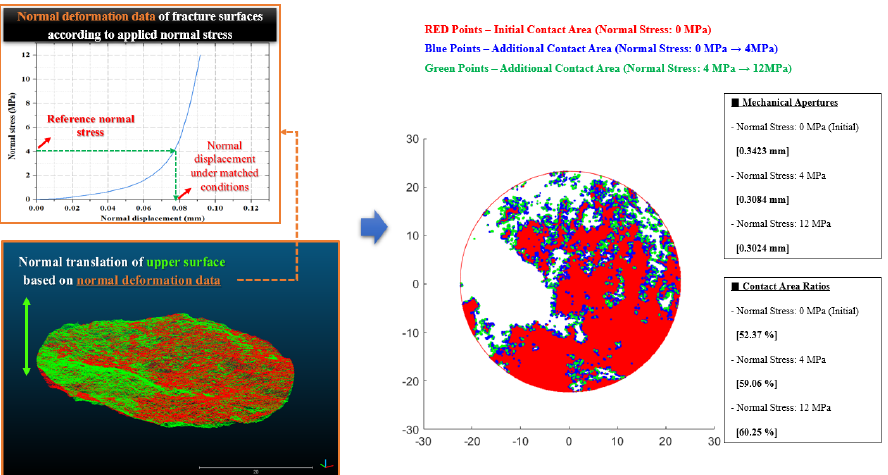
Figure 6. Example of the application result of the translation algorithm considering a normal deformation of fracture.